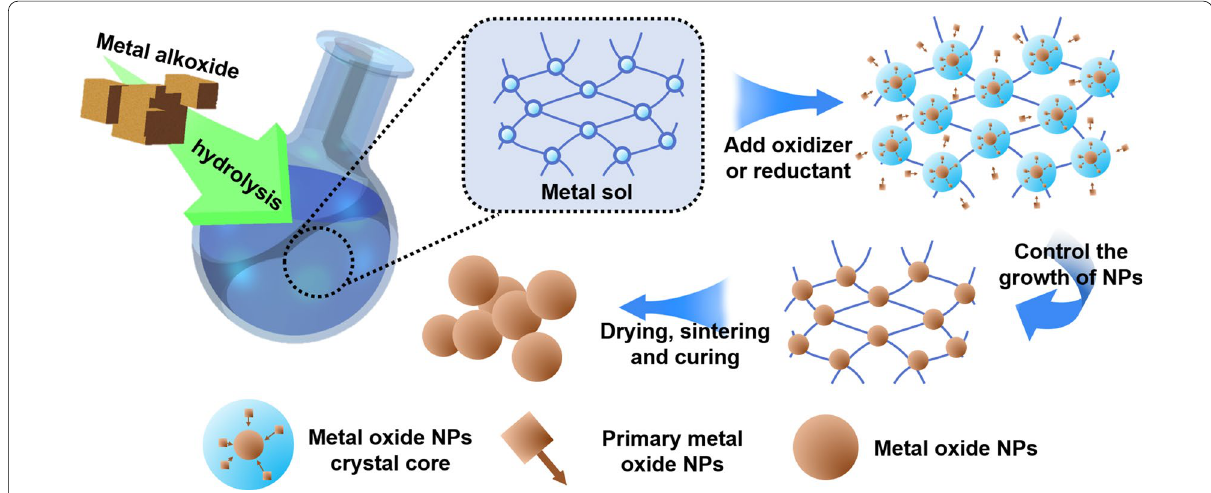
Fig. 1 Schematic diagram of the sol–gel